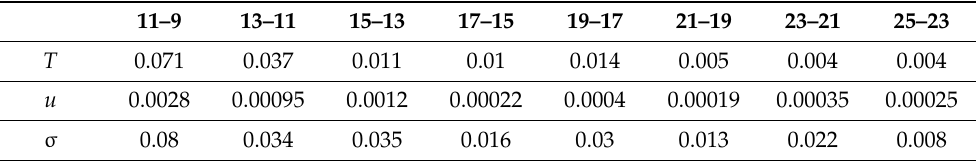
Table 5. The maximum norm for differences (upper row) for temperature, displacement, and stress in the space-time domain in layer 2.